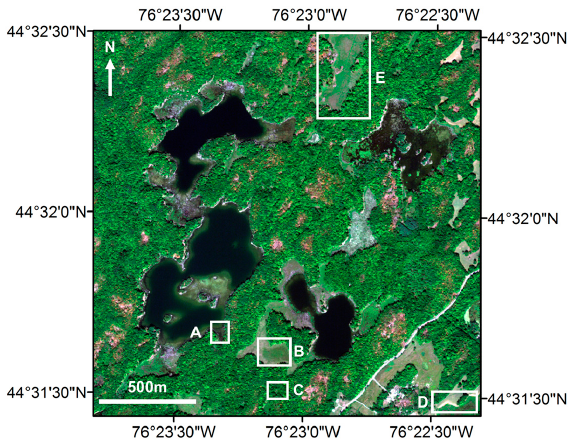
Figure 2. Five in situ field work locations in study area: ( A ) Poole Lake; ( B ) Marsh A; ( C ) Inundated Forest; ( D ) Marsh B; and ( E ) Vegetated Lake.